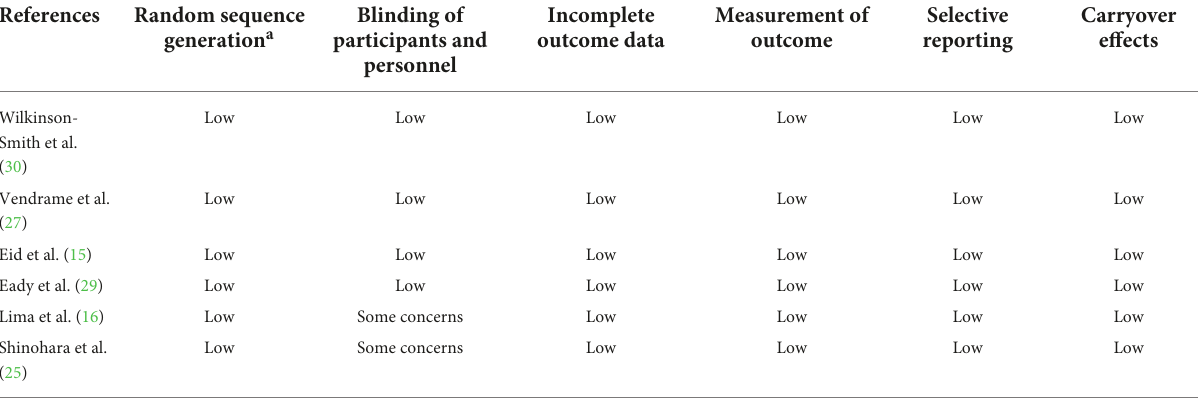
TABLE 3 Risk of bias assessment for crossover trials of the effect of fruits intake on FC.